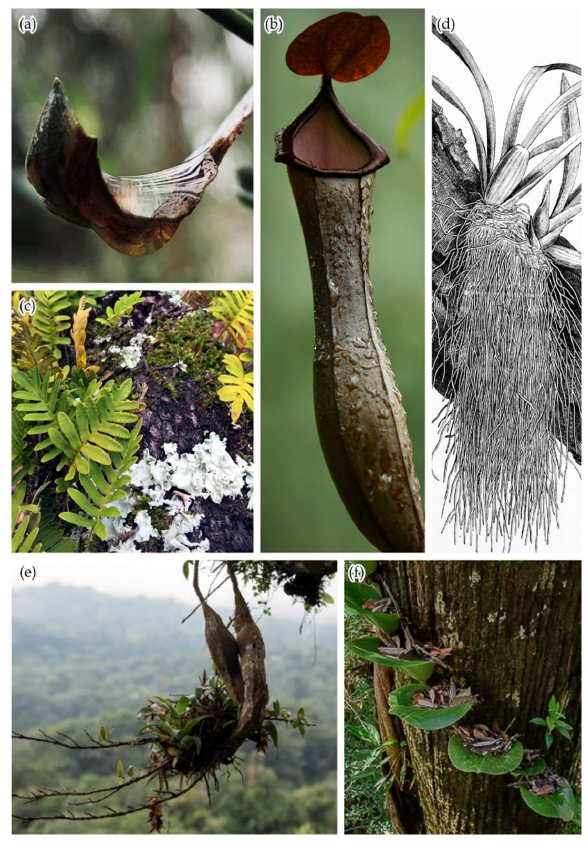
Figure 1. Anatomy of the arboreal epiphyte “bucket” includes: ( a ) water pools called phytotelmata [36], often held in ( b ) tank-like leaves that also externally hold water droplets [37]; ( c ) leaves and leaf-like thallus organs of lichens and bryophytes [38]; ( d ) root and rootlike organs [39] which can include ( e ) external storage structures such as lignotubers [40] and pseudobulbs (not pictured); and ( f ) trapped detritus